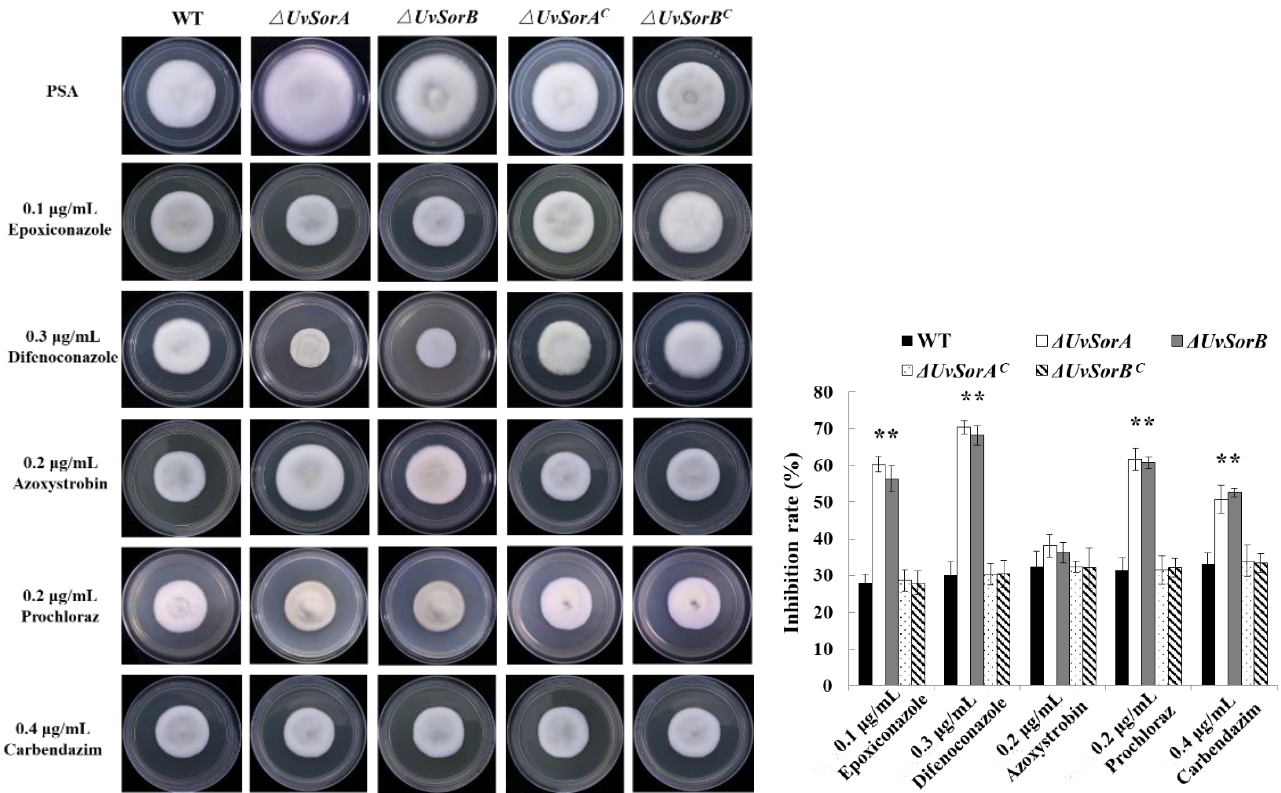
Figure 10. Effects of fungicides on mycelia growth of ∆ UvSorA and ∆ UvSorB mutants. The colony growth of the strains under fungicide stresses (left panel). Statistical analysis of mycelial growth of the strains under fungicide stresses (right panel). Each strain was incubated on PSA supplemented with a certain fungicide at 28 °C for 18 days. Three independent biological experiments were performed with three replicates each time. Error bars represent the standard deviation, and the asterisk (*) represents a significant difference at p < 0.05, ** p < 0.01.